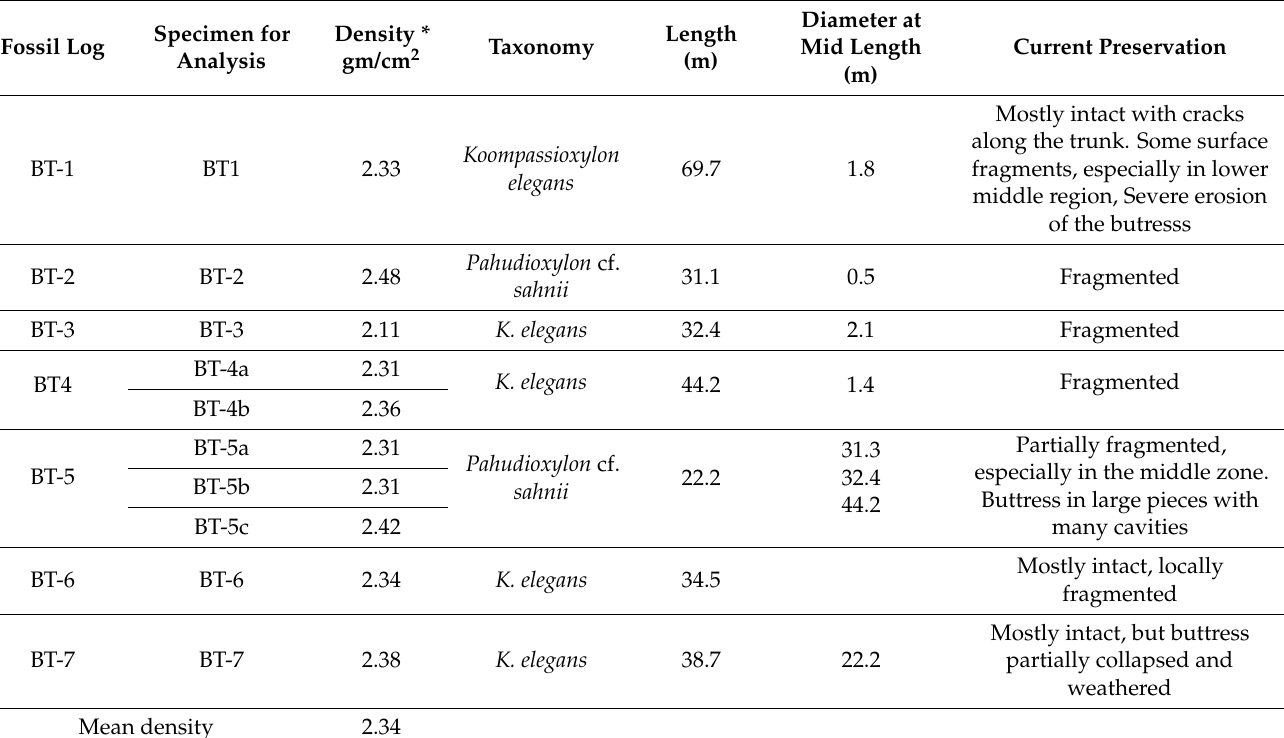
Table 1. Ban Tak specimen list. Data adapted from [4]. Density values determined as part of our